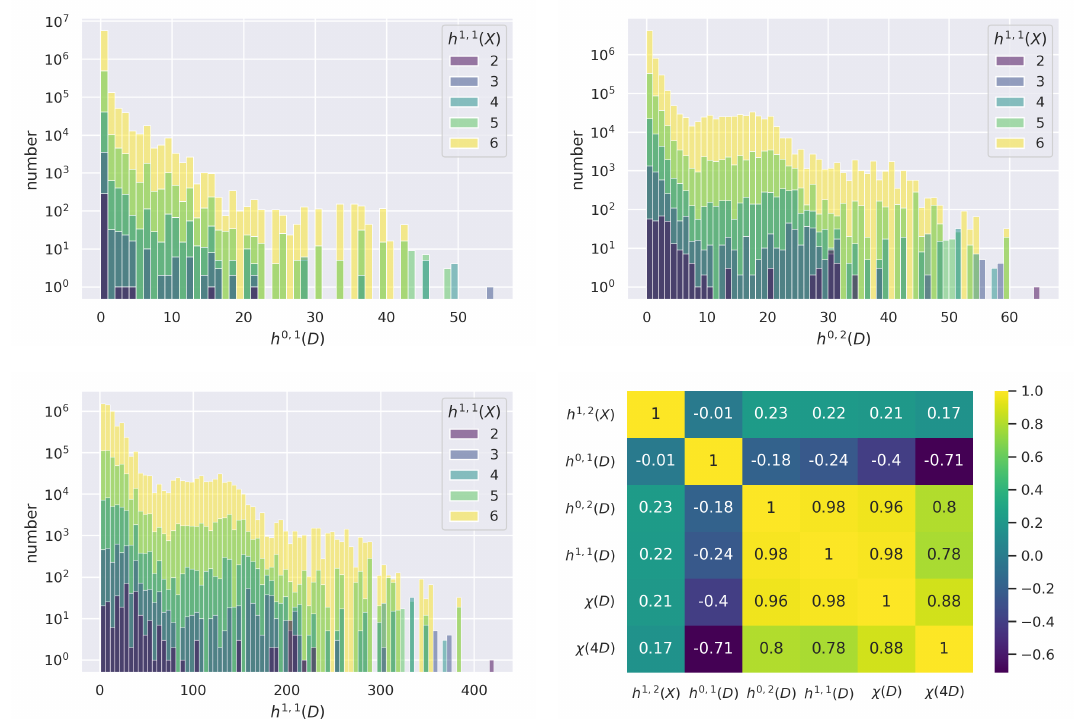
Figure 1 . Histogram plots for Hodge numbers h p,q of all divisors at h 1 , 1 ≤ 6 . We ignore h 0 , 0 given that h 0 , 0 ( D ) = 1 for all D . The bottom right plot shows a correlation map for the relevant divisor and CY